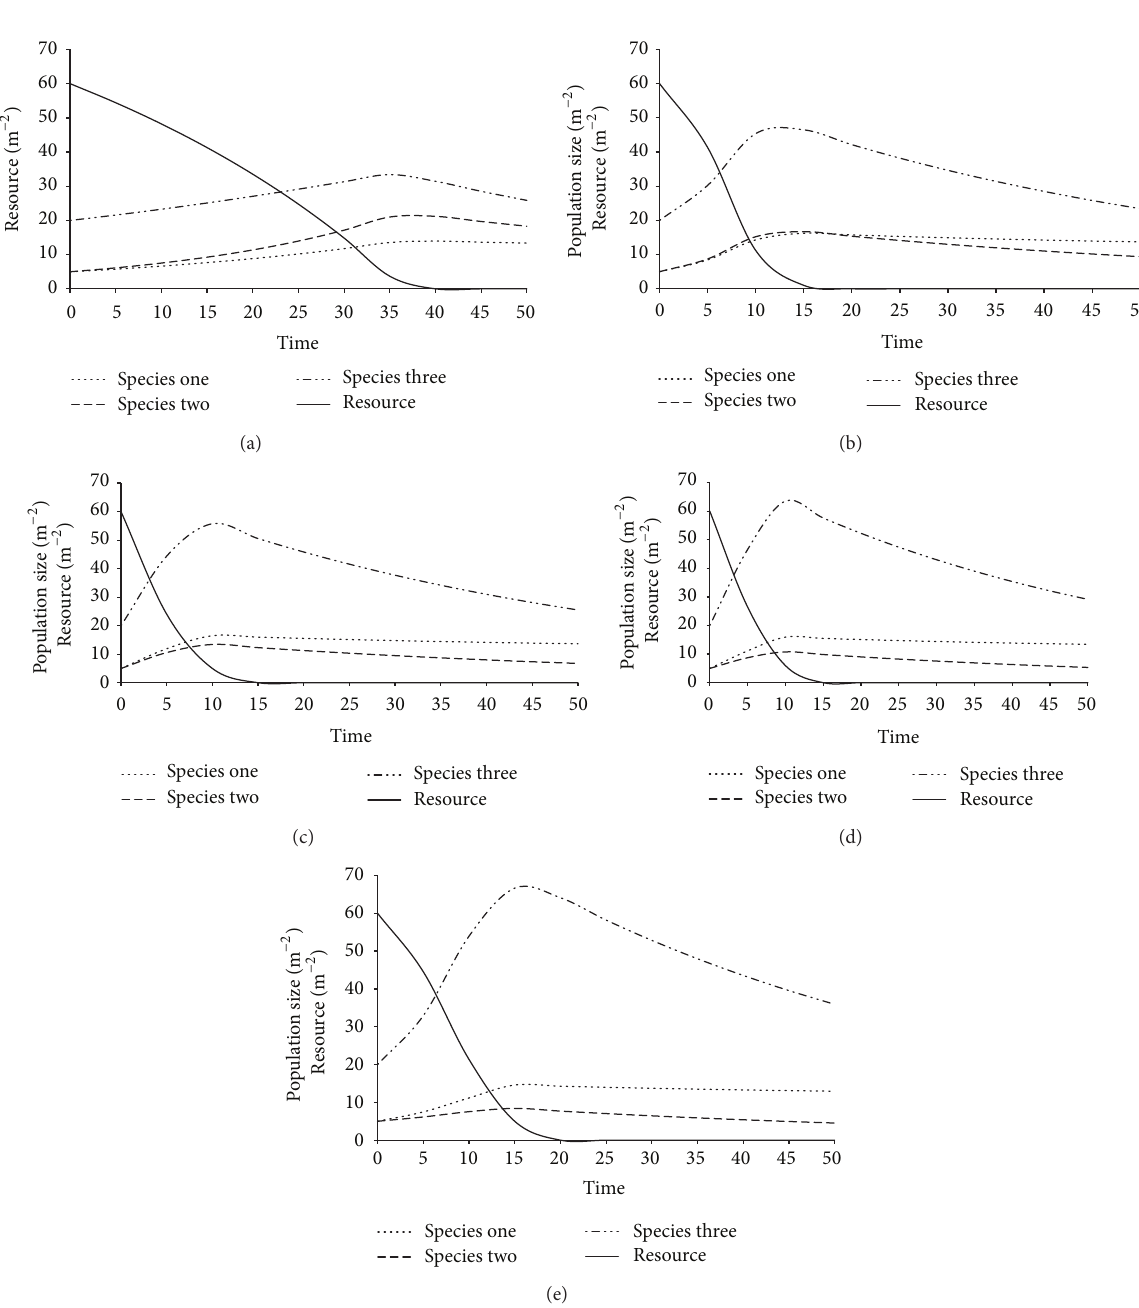
Figure 9: Behavior of the isoclines when the population size of species three is greater than species two and one; curves (a)–(e) show the behavior of population size for each species and the resource at temperatures 10 ∘ C, 15 ∘ C, 20 ∘ C, 25 ∘ C, and 30 ∘ C, respectively. 𝑟 , 𝑖 = 1, 2, 3 : Maximal gross productivity rate of species 𝑖